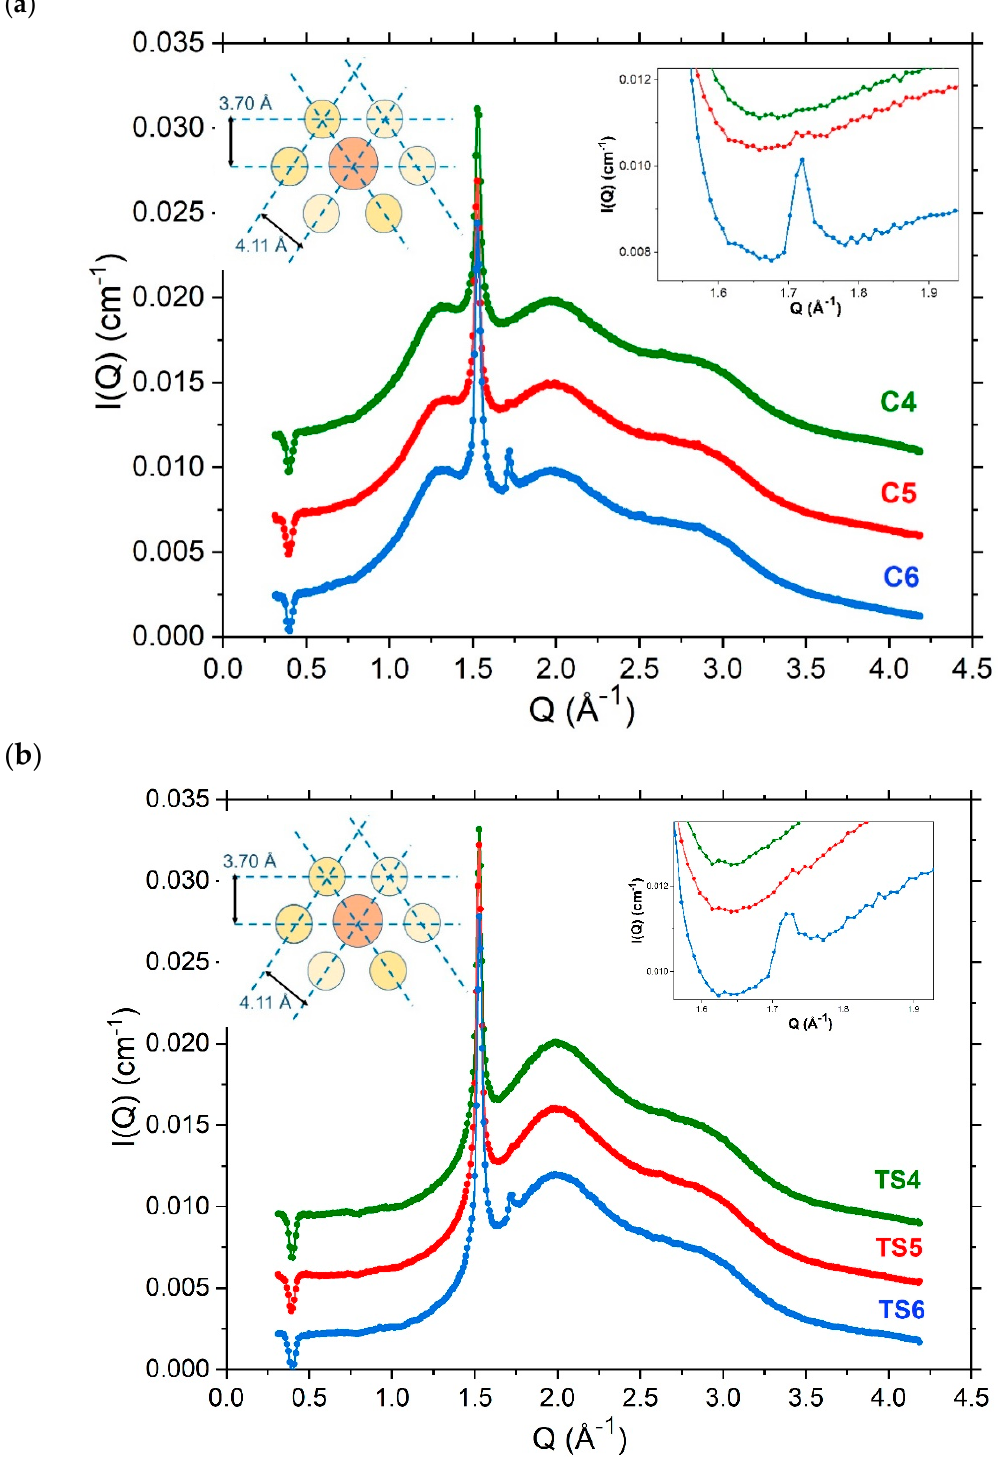
Figure 7. Wide-Angle X-ray Scattering (WAXS) profiles (offset on the ordinate for clarity) recorded at 298 K for 10% creams ( a ) and ternary systems ( b ) containing a 1:1 (green; C4, TS4), 1:0 (red; C5, Table 2. or 0:1 (blue; C6, TS6) hexadecanol:octadecanol co-surfactant ratio. Insets in ( a ) and ( b ) show the profiles enlarged around the peak arising at Q ≈ 1.7 Å − 1 corresponding to an orthorhombic packing of the co-surfactant(s) with the additional schematics depicting the packing of the co-surfactant alcohols and SDS in the layer surrounding each oil droplet. Formulation compositions as provided in Methods, Table 1.